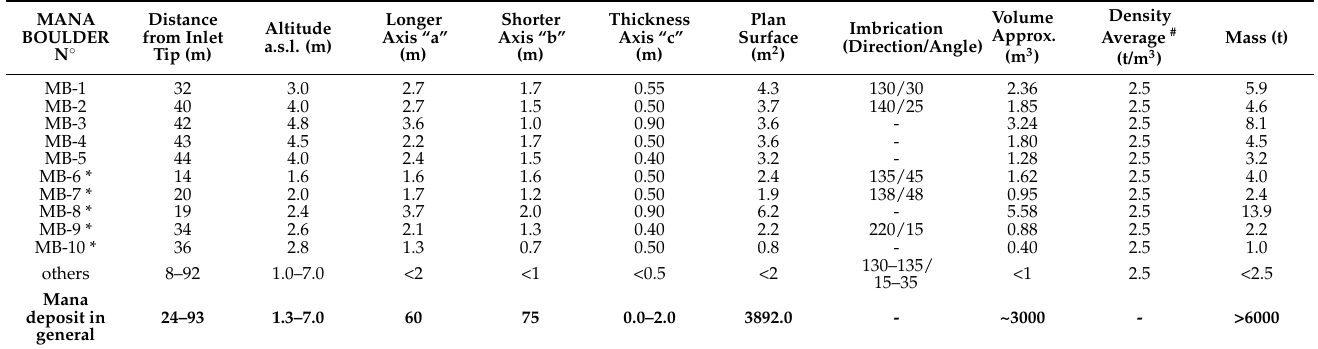
Table 1. Selected boulder data according to the field observations and photogrammetric measure- ments (20 October 2020) and estimation of the Mana storm deposit in general. Marks: * solitary boulders out of the unified deposit. # average bulk density is evaluated according to the professional data on mechanical properties of the most popular types of Cretaceous dimension limestone from regions that are similar to Mana limestones